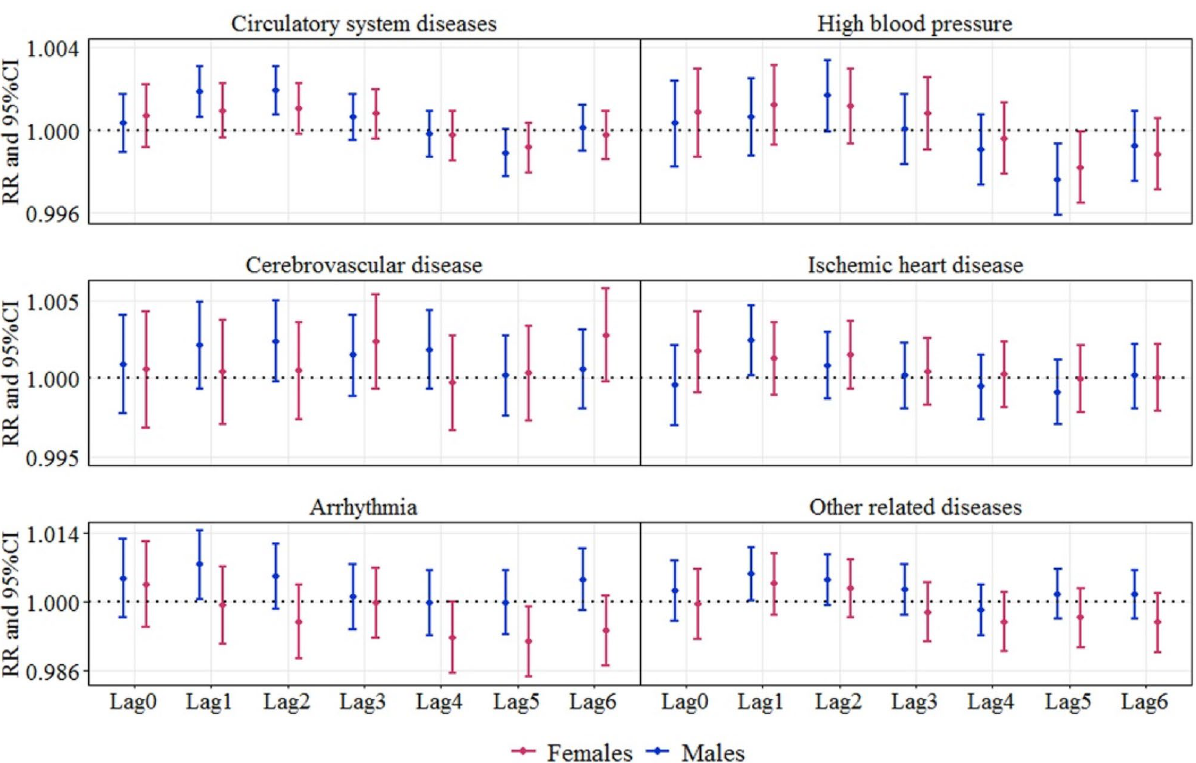
Figure 4. Relative risks (with 95% CI) of emergency room visits for every 10 μg/m 3 increase in PM 10 (lag 0–6) under the sex stratification.